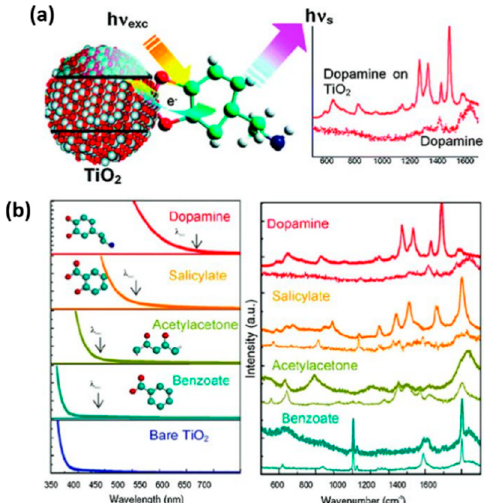
Figure 7. ( a ) Schematic illustration of SERS performance of dopamine adsorbed on TiO 2 nanoparticles. ( b ) Absorption and SERS spectra of TiO 2 nanoparticles modified with different ligands. Reprinted from Ref. [33] with permission from American Chemistry